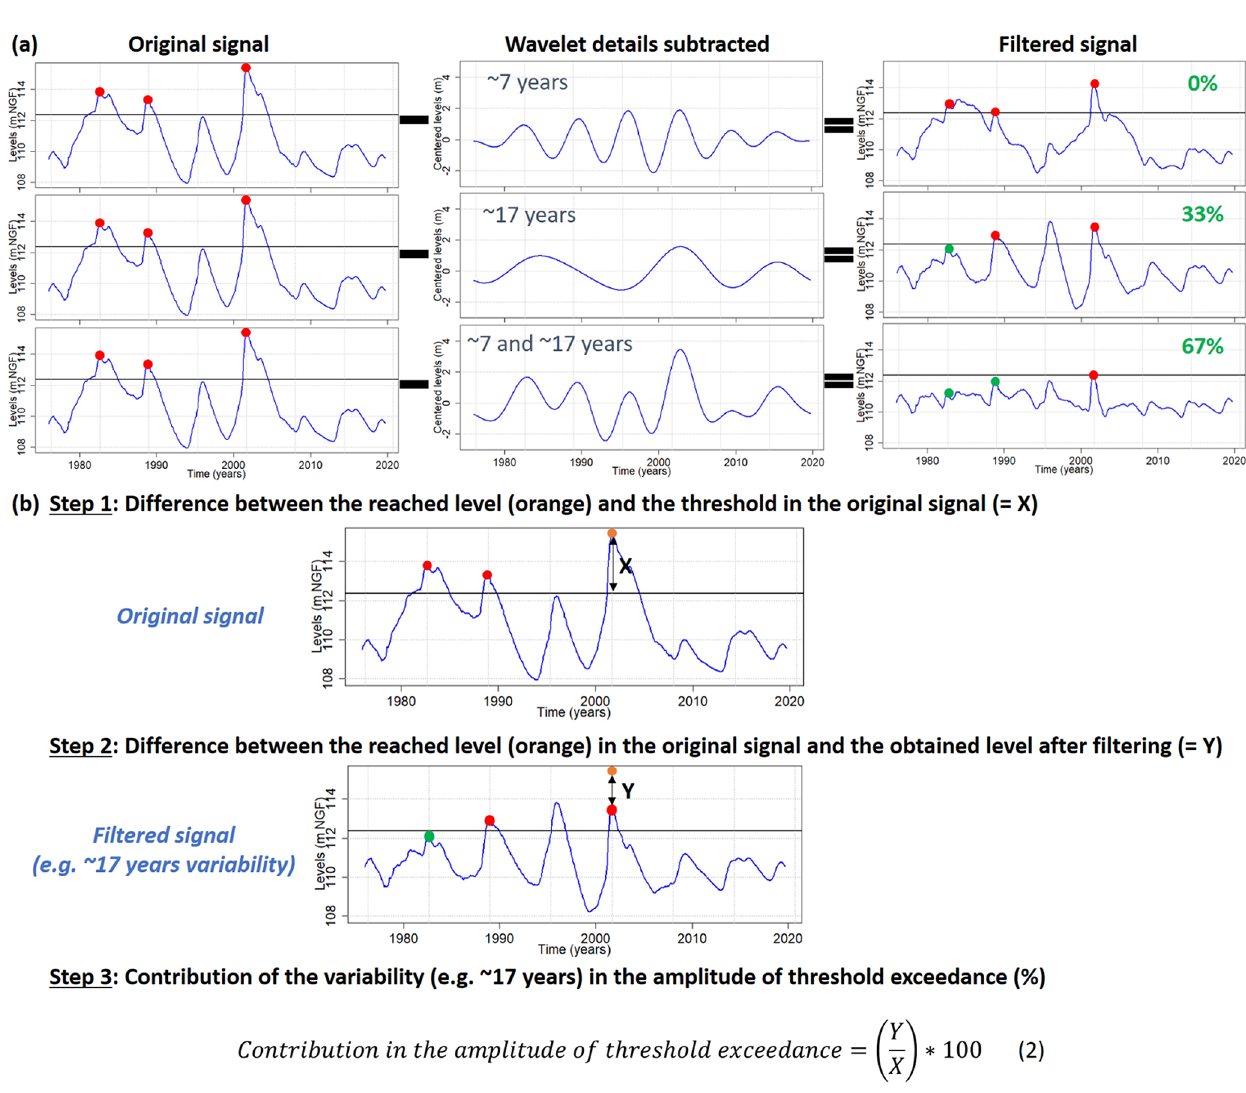
Figure 4. Workflow of (a) the influence of low-frequency variability on high and low groundwater level occurrence (example of high levels) and (b) the contribution of low-frequency variability to the amplitude of threshold exceedance. The borehole of Goupillières (chalk of Normandy) is taken as an